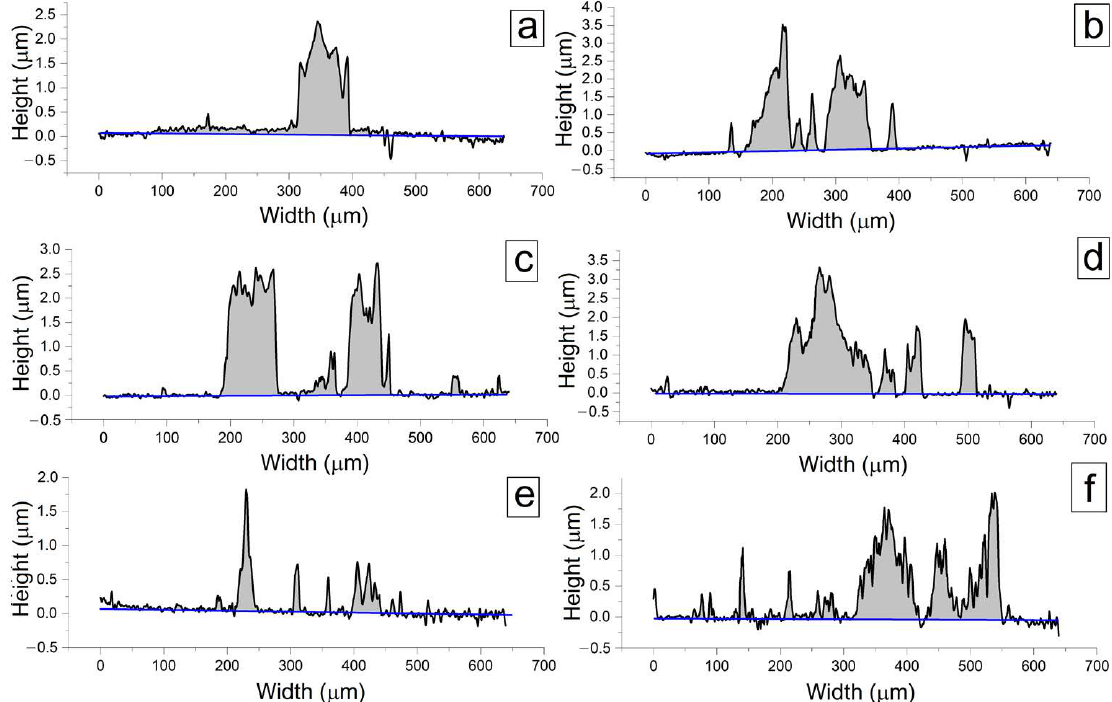
Figure 6. The wear track cross-section profiles on ZrN ( a ), CrN ( b ), ZrCrN(0.5) ( c ), ZrCrN(3.5) ( d ), ZrCrN(5) ( e ) and ZrCrN(8) ( f ) samples after sliding at 1 H.